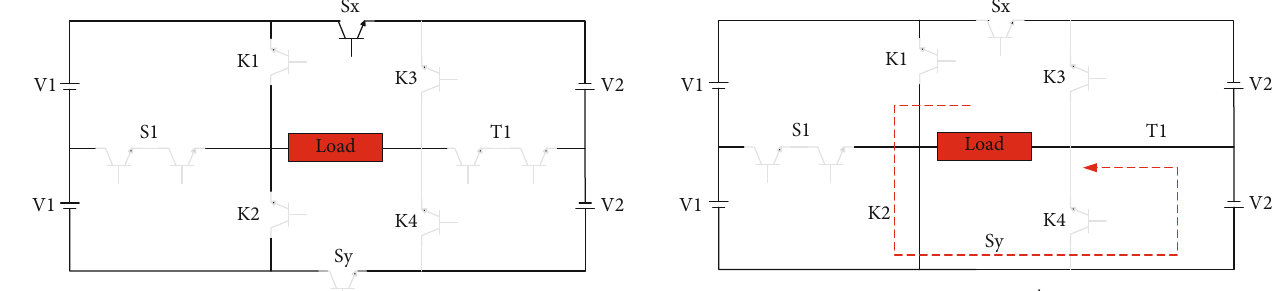
Figure 6: Current fl ow for the 4 th switching pattern.